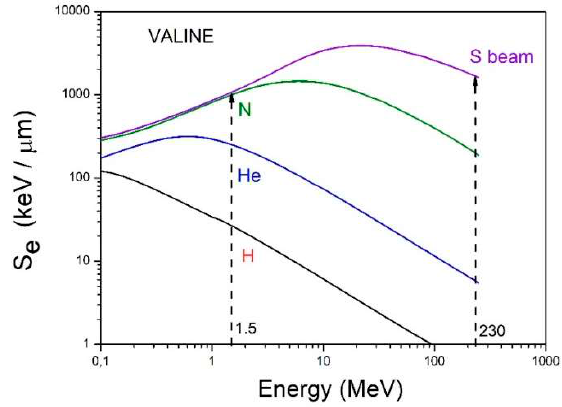
Figure 11. Dependence of electronic stopping power on projectile (H, He, N and S) energy. Dash lines indicate the two ion beam energies used in the current work.